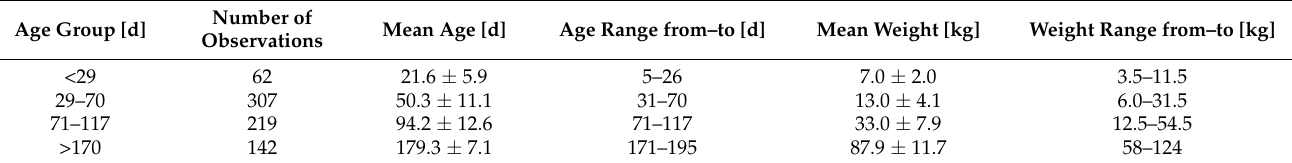
Table 1. Information regarding the different age and weight groups in